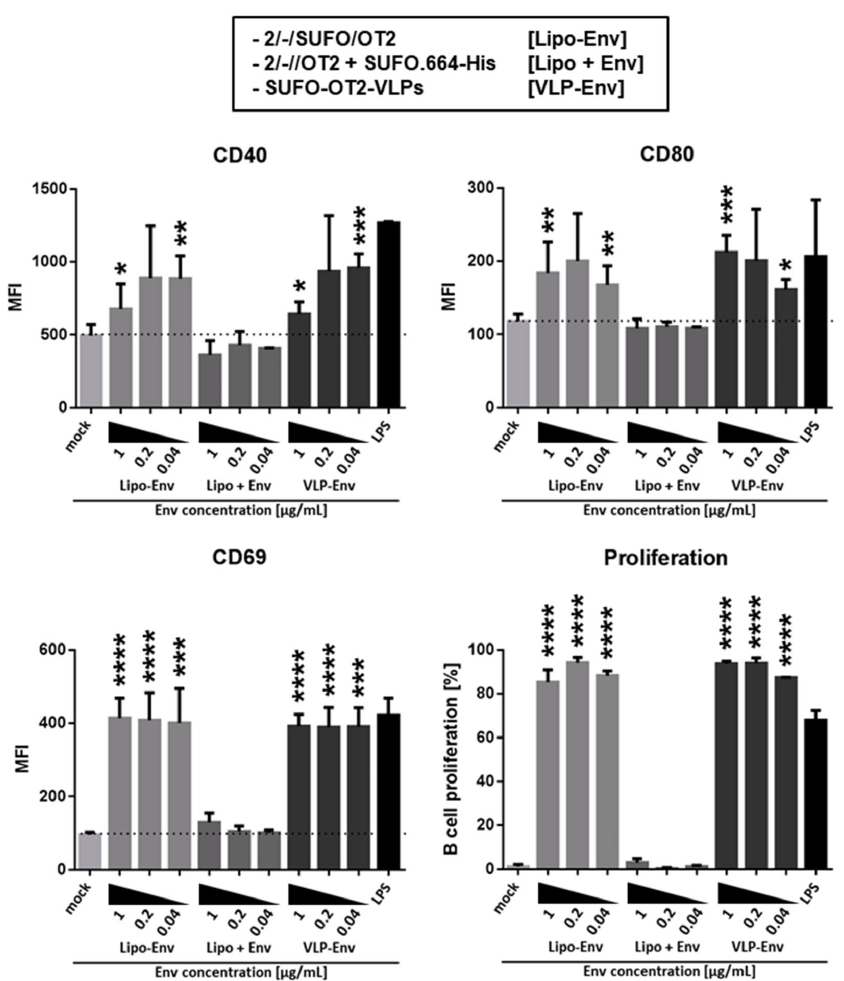
Figure 5. Functional evaluation of second ‐ generation T helper liposomes. In vitro B cell activation assay with second ‐ generation liposomes. Splenic PGT121 B cells — optionally labeled with a CFSE proliferation marker — were incubated with 2 ‐ Gen 2/ ‐ /SUFO/OT2 liposomes (Lipo ‐ Env), lentiviral T helper SUFO ‐ OT2 ‐ VLPs (VLP ‐ Env) or a mixture of uncoupled 2/ ‐ //OT2 and soluble SUFO.664 ‐ His trimers (Lipo + Env) with matching bulk Env (1–0.04 μ g/mL) and lipid concentra ‐ tions. An amount of 2 × 10 5 CFSE ‐ B cells were seeded for activation assays and 1.5 × 10 5 CFSE+ B cells were seeded for proliferation assays. As a positive control, B cells were incubated in the presence of 1 μ g/mL LPS. Activation was defined by upregulation of markers CD40, CD80 and CD69. The mean values of the median fluorescence intensities (MFI) of three independent experi ‐ ments are represented by the columns ± SD. * p < 0.05; ** p < 0.005; *** p < 0.001; **** p < 0.0001; or ‐ dinary one ‐ way ANOVA and Tukey’s multiple comparisons test were conducted between groups with matching bulk Env concentrations; asterisks indicate significant differences of Lipo ‐ Env and/or VLP ‐ Env compared to Lipo + Env. 4. Conclusions T helper nanoparticles are defined by displaying the antigen of interest on the sur ‐ face and encapsulating heterologous T helper epitopes in order to modulate humoral immune responses by intrastructural help. Lentiviral T helper VLPs were predominantly